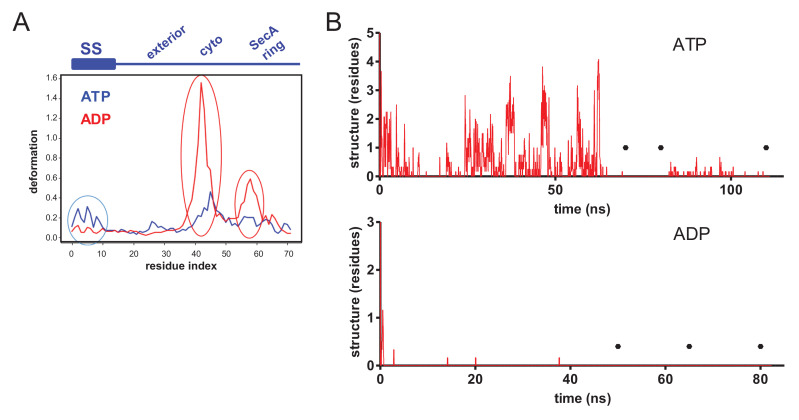
Pre-protein structural changes in the channel.(A) Deformation energy plotted as a function of residue index in substrate, starting from N-terminus of signal peptide (ATP state in blue, ADP state in red). The position in relation to the pre-protein is shown in the blue schematic above the graph. Three distinct regions with higher deformation energy are clearly visible and highlighted by ovals; in the signal sequence (‘SS’), the cytoplasmic cavity (‘cyto’) and SecA ring. These data are used for visualisation in Figure 2B. (B) The degree of hydrogen bonded secondary structure in the 18 residue stretch of glycine residues through the SecY channel, as determined using the dihedral-based DSSP analysis. The y-axis shows the number of residues considered secondary structure in each frame of the simulation. Note that the higher degree of secondary structure in the ATP-bound state meant that additional simulation time was required (top). Black circles mark the times that snapshots were taken for further analyses.